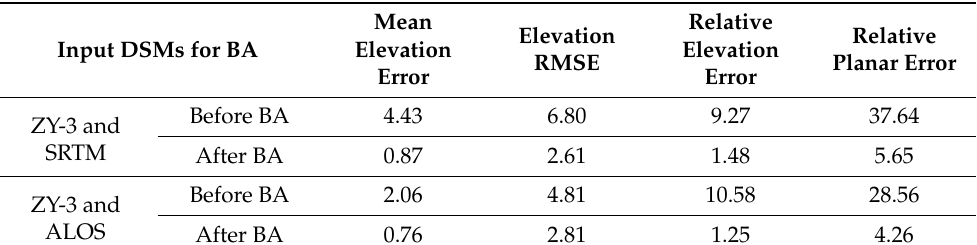
Figure 10. Elevation accuracy of the check points before and after block adjustment for the ALOS and ZY-3 DSMs. Table 3. Accuracy of the multisensory DSMs before and after block adjustment (unit: meters).